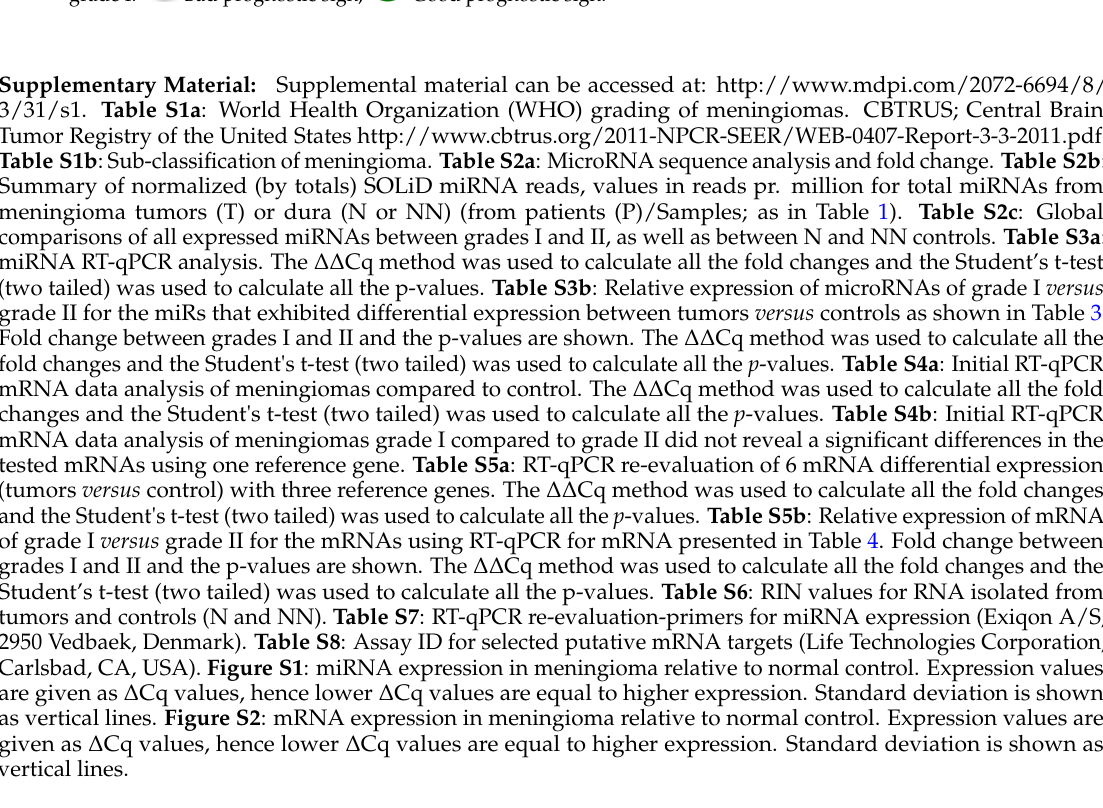
Table 6. Summary of putative pro- and anti-proliferation differentially expressed miRNAs and mRNAs/proteins in meningioma.